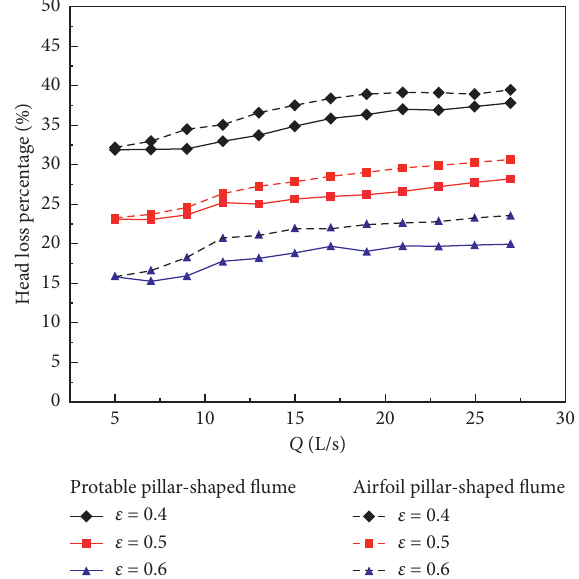
Figure 12: Relationship between the head loss and flow rate at different contraction ratios.